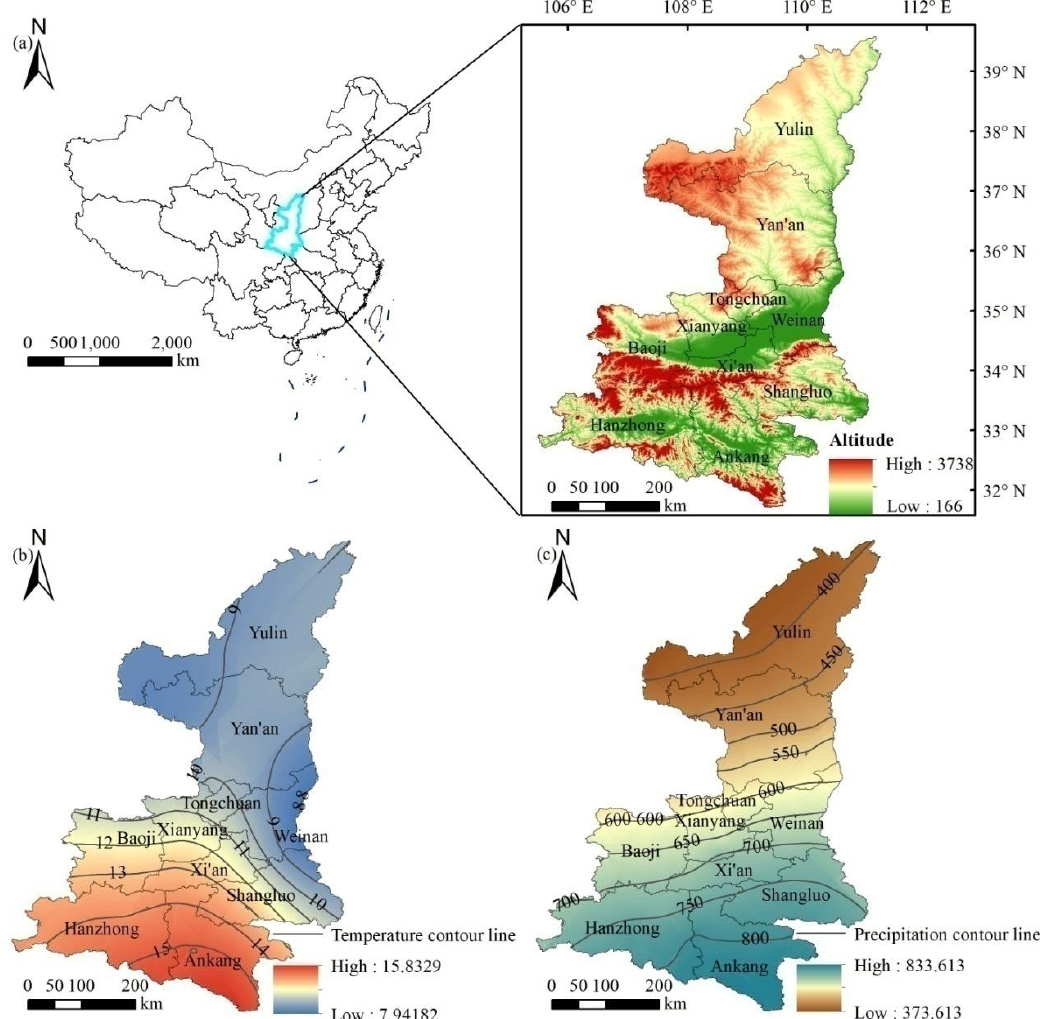
Figure 1. Geographical location, geographical boundaries, and the overview of physical geography (dem, temperature, and precipitation) of the study area (The dotted lines in left panel of ( a ) displays the geographical boundaries of China, the right panel of ( a ) displays altitude of Shaanxi province; ( b ) is the spatial distribution of annual average temperature (the units is °C); ( c ) is the spatial distribution of annual average precipitation (the units is mm). Table 1. Different types of NDVI change trend and significance test (F-value: the significance of F-test; p -value: the signif- icance of linear regression model; b: the slope of linear regression model. When b > 0, the annual NDVI value shows an upward trend; when b < 0, the annual NDVI value shows a downward trend).